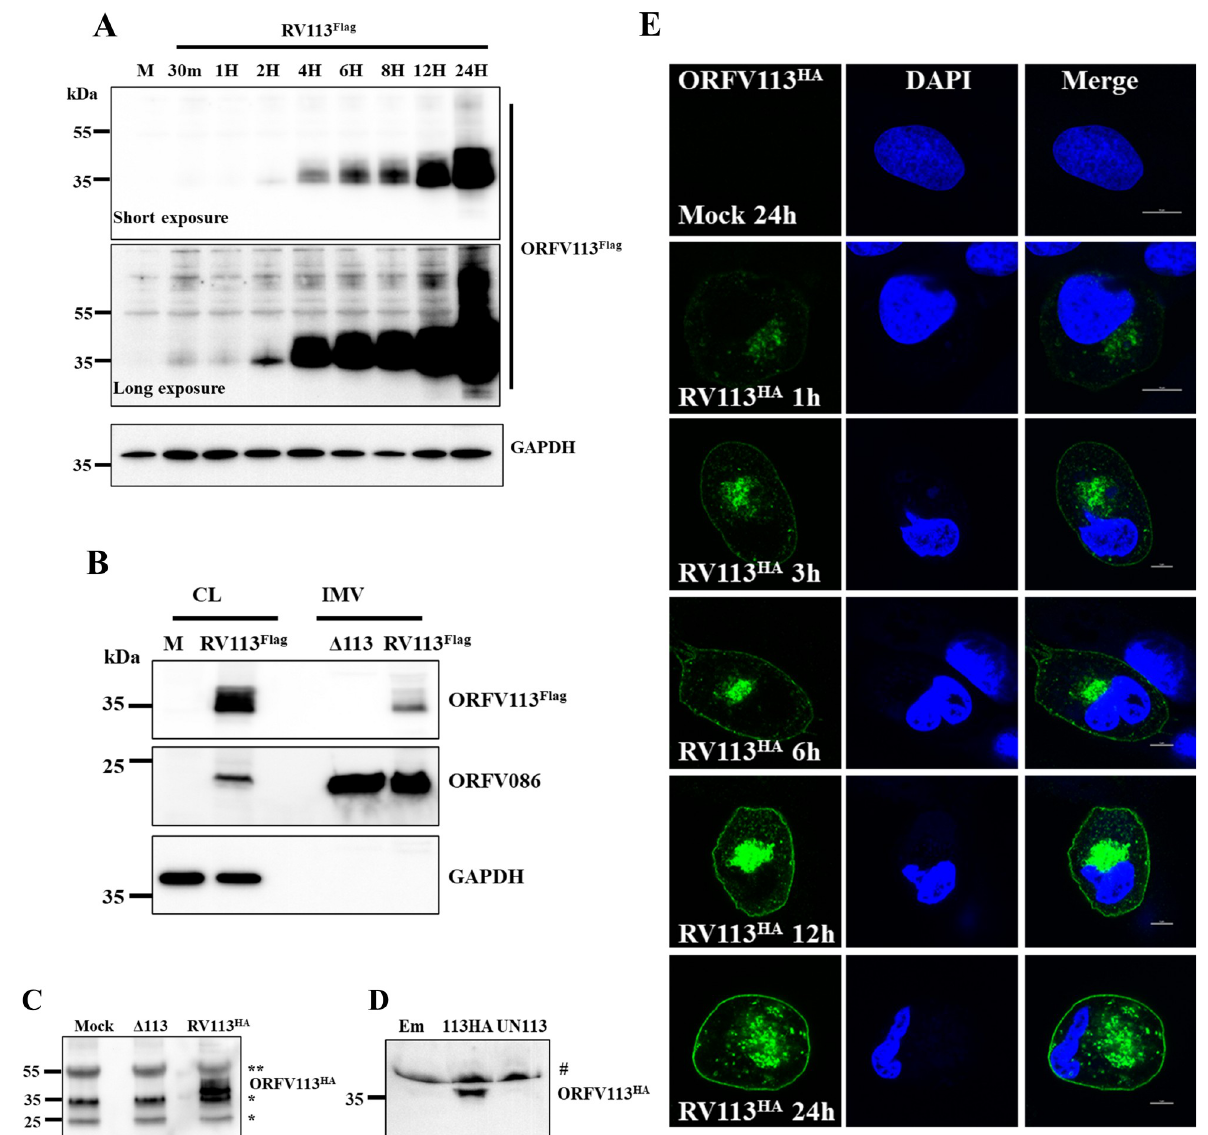
Fig 1. ORFV113 expression kinetics, presence in virions and supernatants, and subcellular localization. (A) Kinetics of ORFV113 expression. OFTu cells mock infected (M) or infected with revertant virus OV-IA82-RV113 Flag (MOI, 10) were harvested at indicated times p.i. Total cell protein extracts were resolved by SDS-PAGE, blotted and incubated with antibodies against Flag and GAPDH. Result is representative of two independent experiments. (B) Detection of ORFV113 in virions. OFTu cells were infected with OV-IA82- Δ 113 ( Δ 113) or OV-IA82-RV113 Flag (RV113 Flag ), and intracellular mature virions (IMV) were purified through double sucrose gradient centrifugation. Whole cell lysate (CL) (50 μ g) from OFTu cells mock infected or infected with OV-IA82-RV113 Flag , and purified virions (10 μ g) were resolved by SDS-PAGE and analyzed by Western blot using antibodies against Flag, structural protein ORFV086 or host GAPDH. Result is representative of three independent experiments. (C and D) Presence of ORFV113 in supernatant of ORFV infected cells and ORFV113 transiently expressing cells. (C) OFTu cells mock infected (M) or infected with OV-IA82- Δ 113 or OV-IA82-RV113 HA (MOI, 10) were harvested at 24 h p.i. Immunoprecipitation was performed on clarified culture supernatant and immunoprecipitation products were resolved by SDS-PAGE, blotted and incubated with antibodies against HA. Result is representative of two independent experiments. (D) Culture supernatants were harvested from OFTu cells transfected with pCMV-HA (Empty HA plasmid), pCMV-ORFV113 HA (ORFV113 HA plasmid) or pCMV-ORFV113 (Untagged ORFV113 plasmid) at 24h post transfection. 50 μ l of the culture supernatants were resolved by SDS-PAGE, blotted and incubated with antibodies against HA. Result is representative of three independent experiments. # indicates non-specific reactivity with serum protein routinely observed in supernatants. (E) ORFV113 subcellular localization. OFTu cells were mock infected or infected with OV-IA82-RV113 HA (MOI, 10), fixed at 1, 3, 6, 9, 12 and 24 h p.i. sequentially incubated with primary antibody against HA and Alexa fluor 488 labeled secondary antibody, counterstained with DAPI and examined by confocal microscopy.